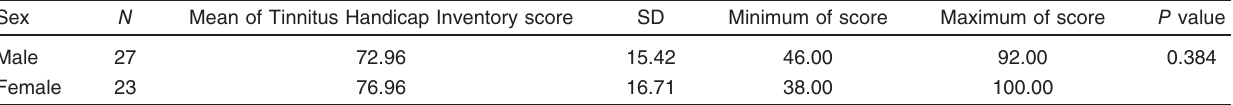
Table 7 shows that the Tinnitus Handicap